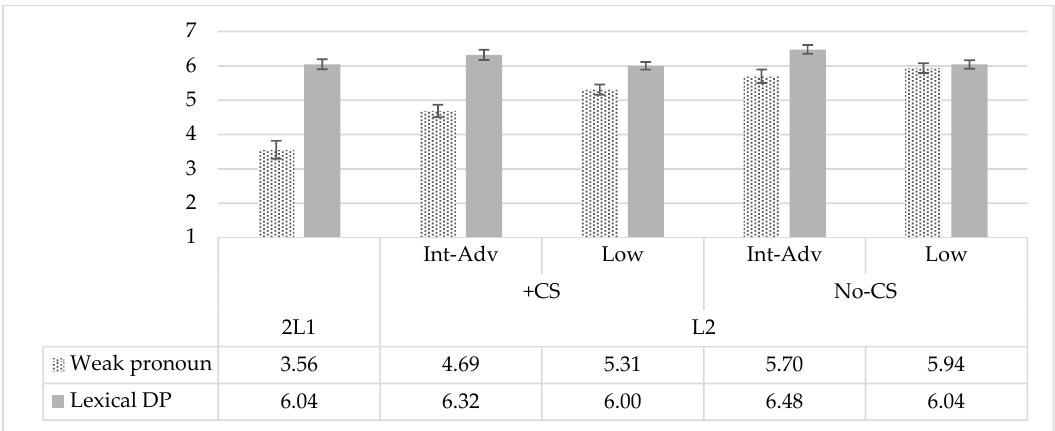
Figure 8. Code-switched subject stimuli ratings by group and type.